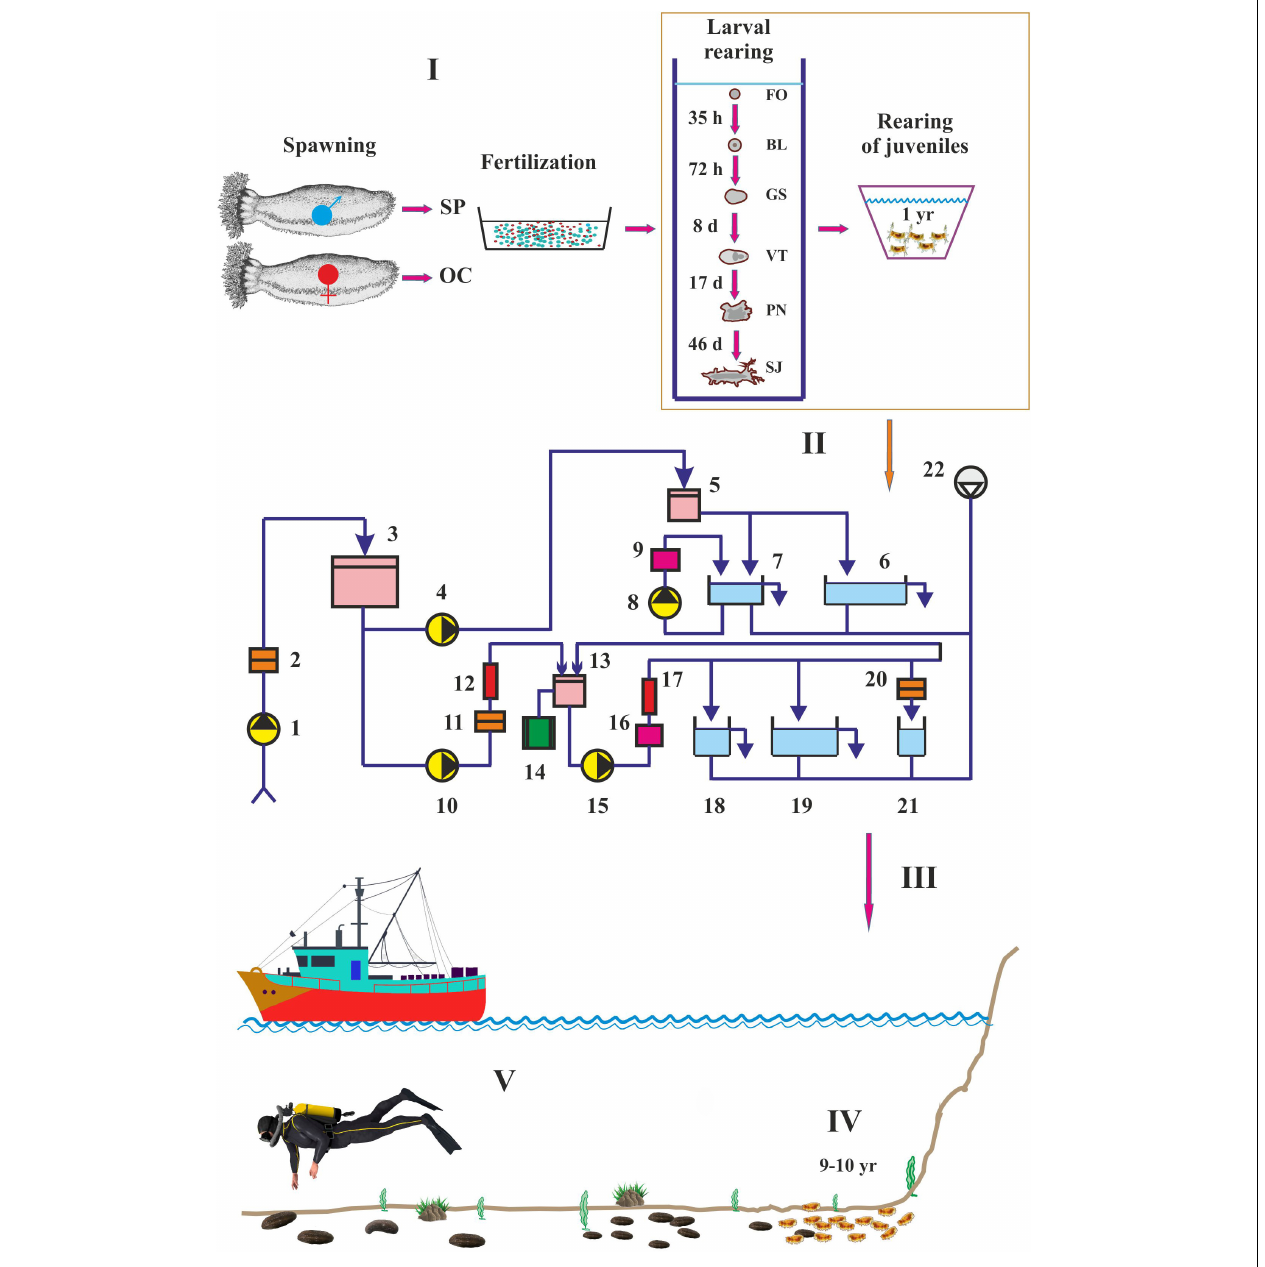
FIGURE 2 | Cultivation of Cucumaria frondosa. I – fertilization under laboratory conditions, II – schematic diagram of the TINRO commercial rearing system, III – transfer of juveniles on the seafloor, IV – sea ranching, V – harvesting (adopted from Hamel and Mercier, 1996; Gavrilova et al., 2006). SP, sperm, OC, oocytes. FO, fertilized oocytes, BL, blastula, GS, gastrula, VT, vitellaria, PN, pentactula, SJ, settled juvenile. 1, 4, 8, 10, 15 – pump for seawater; 2 – filter (pore diameter 150–200 µ m); 3 – septic tank; 5, 13 – water can; 6 – holding tank for juveniles; 7 – broodstock tank; 9, 16 – chiller, 11 – micro-filter (pore diameter 20–40 µ m);